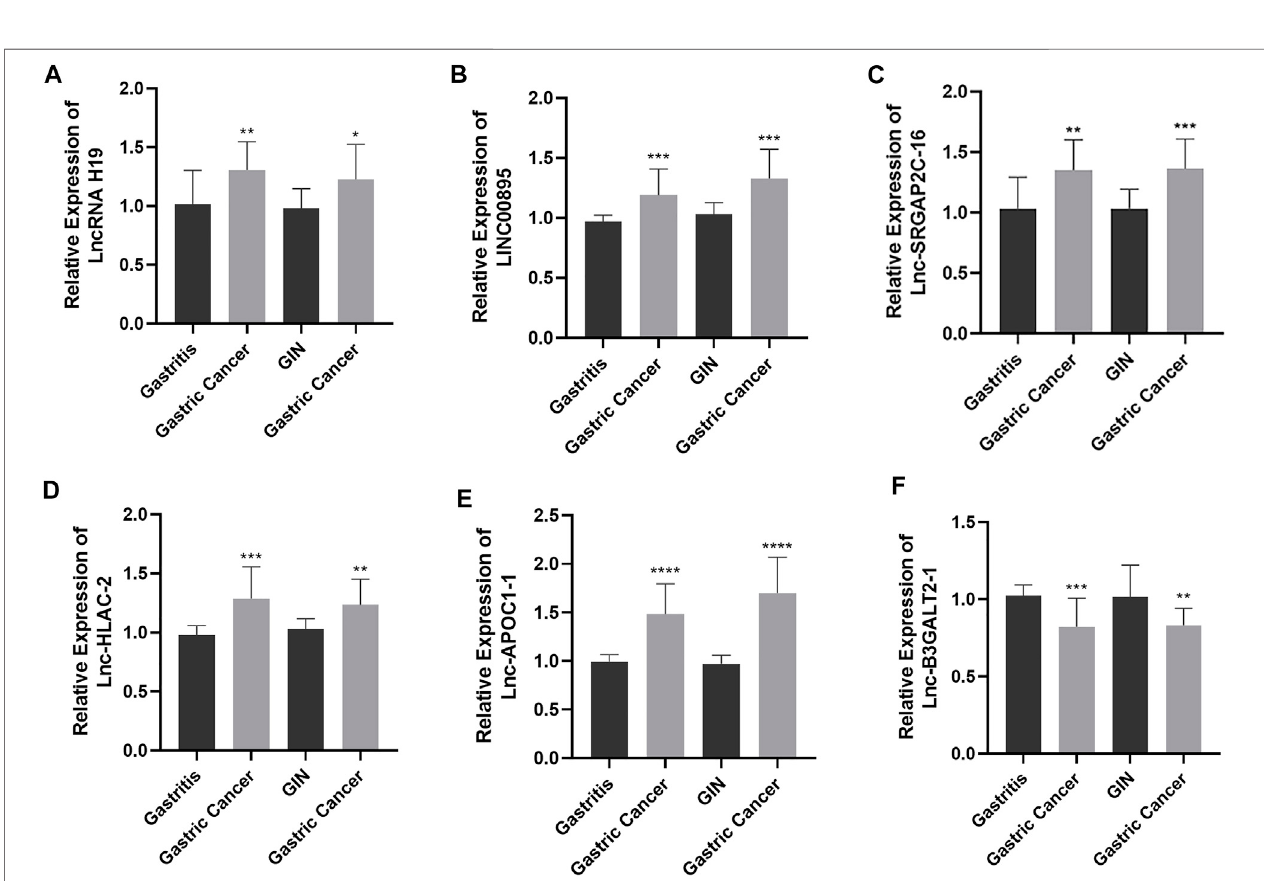
FIGURE 2 | The expression levels of lncRNA H19 (A) , LINC00895 (B) , lnc-SRGAP2C-16 (C) , lnc-HLA-C-2 (D) , lnc-APOC1-1 (E) , and lnc-B3GALT2-1 (F) in chronicnon-atrophicgastritis(Gastritis)vs.gastriccancer(GastricCancer)tissuesandingastricmucosallow-grade/high-gradeintraepithelialneoplasia(GIN)vs.gastric cancer (Gastric Cancer)